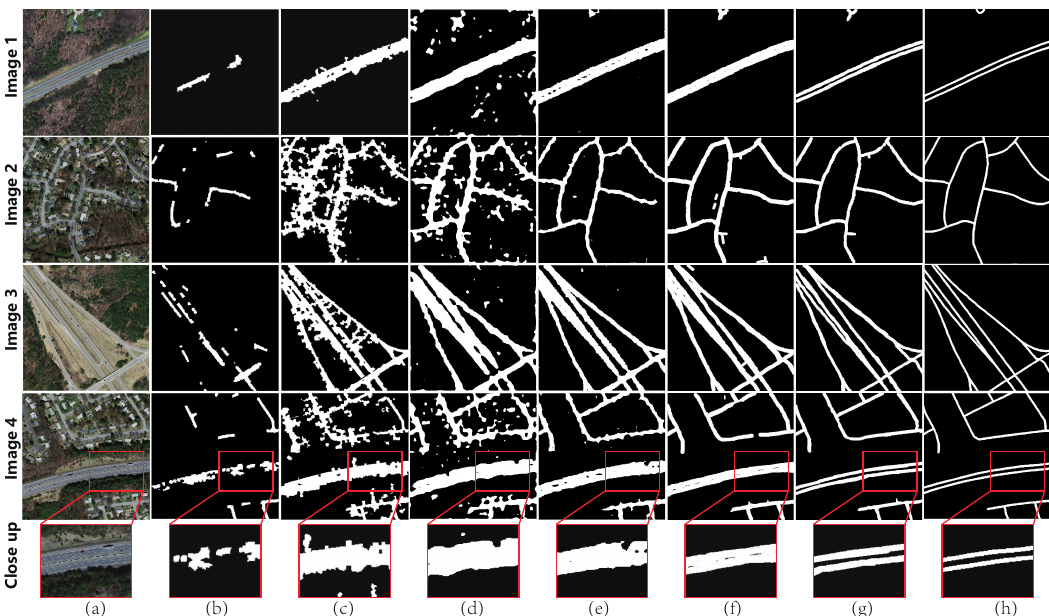
Figure 8. Comparison with state-of-the-art methods (the results in [17,22,43,52] were provided by Wei et al. [22]): ( a ) original image; ( b ) result of [17]; ( c ) result of [52]; ( d ) result of [43]; ( e ) result of [22]; ( f ) result of [11]; ( g ) result of McGAN; and (h ) ground